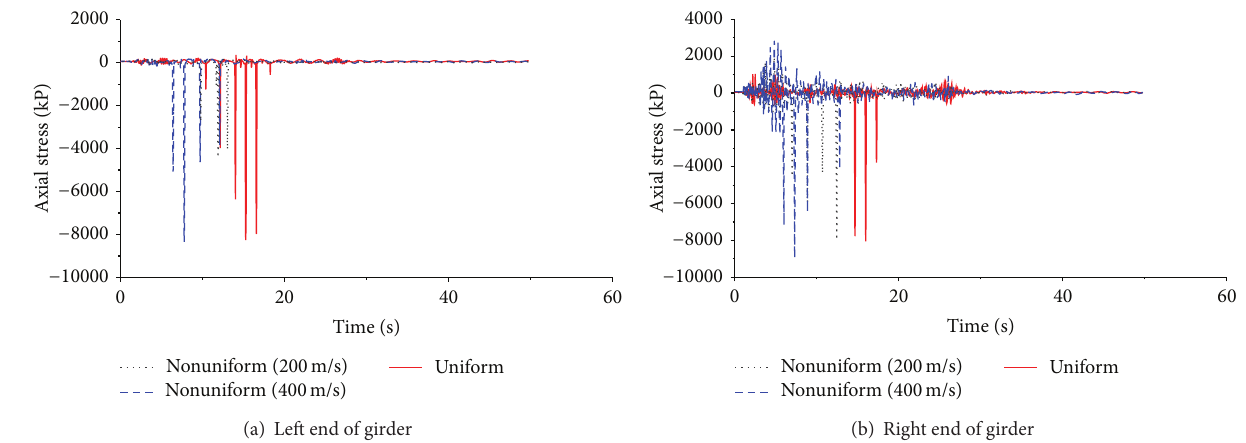
Figure 13: Time history response of axial stress in steel